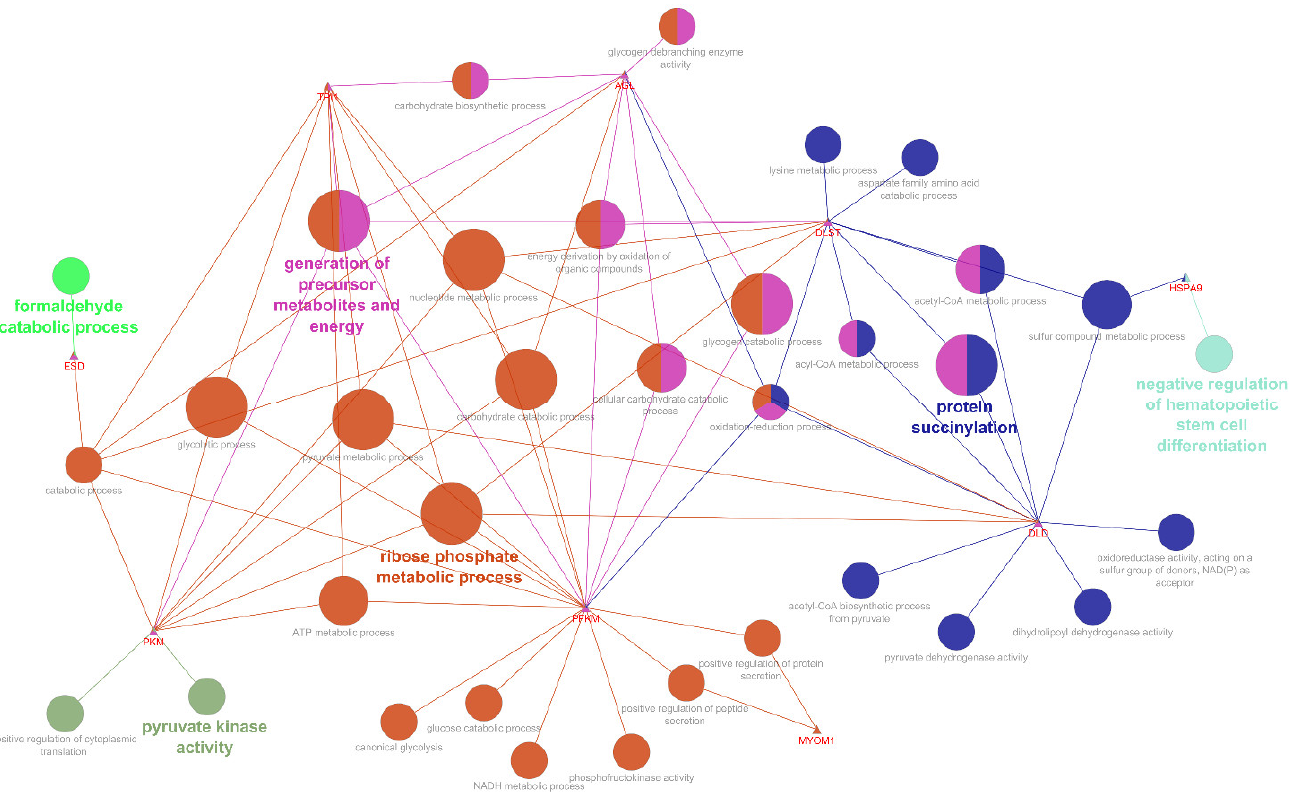
Figure 3. Analyses of the enriched biological process from the differentially abundant proteins (DAPs). The triangles represent the protein names, while the circles represent the biological processes. Different node color means distinct functional group, and node size means the significance. The most significant (FDR < 0.05) term is labeled with bold